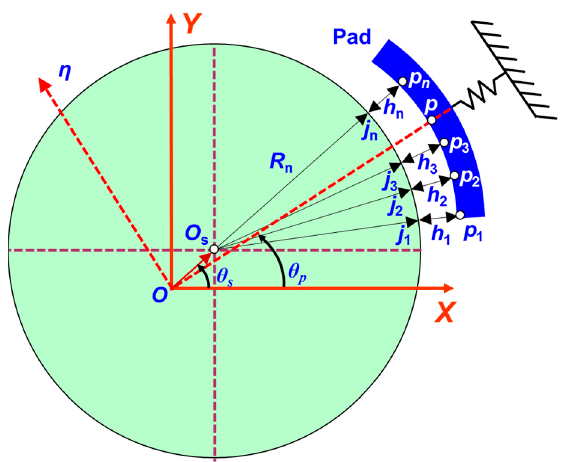
Figure 3. Schematic of flexible tilting pad model with nodal film thickness.